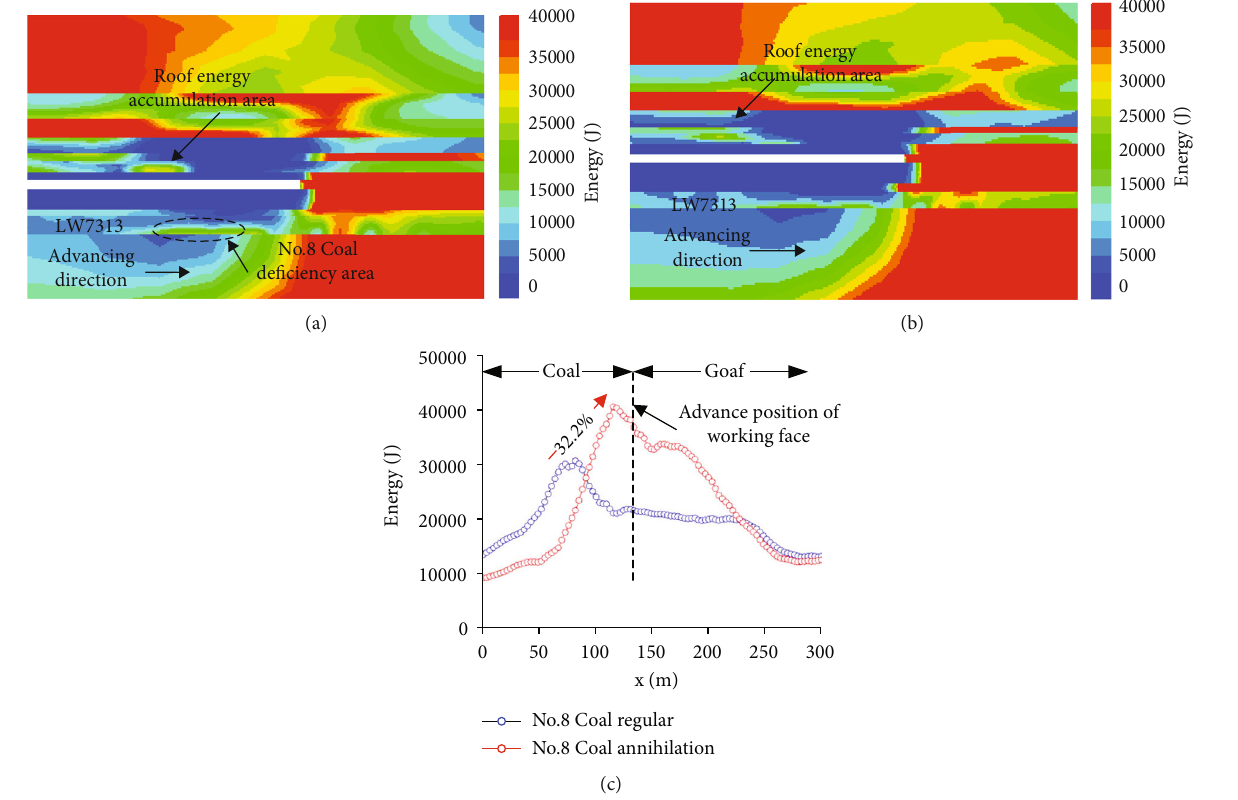
Figure 14: Energy distribution of roof on the working face strike: (a) scheme ① with No. 8 coal missing area; (b) scheme ② without No. 8 coal missing area; (c) energy evolution curve of the working face roof (strike).